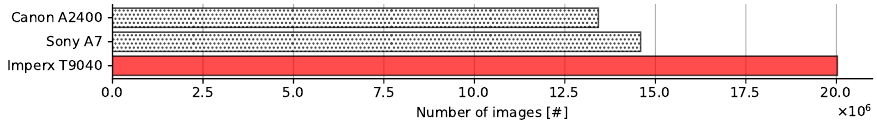
Figure 18. Number of acquired images in a single day for the entirety of Europe from all flights.